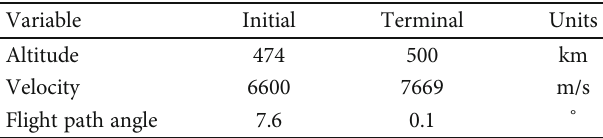
Figure 2: Schematic diagram of program angle segment design of vacuum segment. Table 1: The initial trajectory